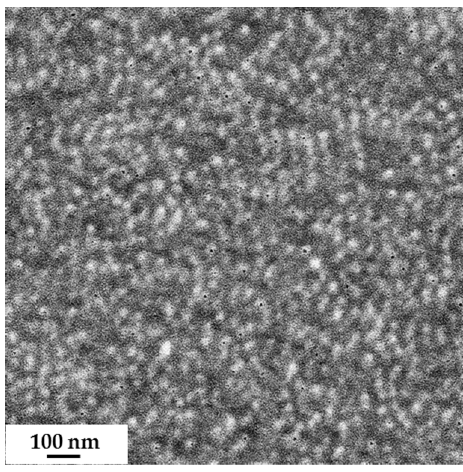
Figure 3. TEM image of an ultra-thin section of PS 81 - b -PSMA 19170 , film cast from 5 wt % polymer in THF; the diameter of the brighter spheres is approximately 25-30 nm.